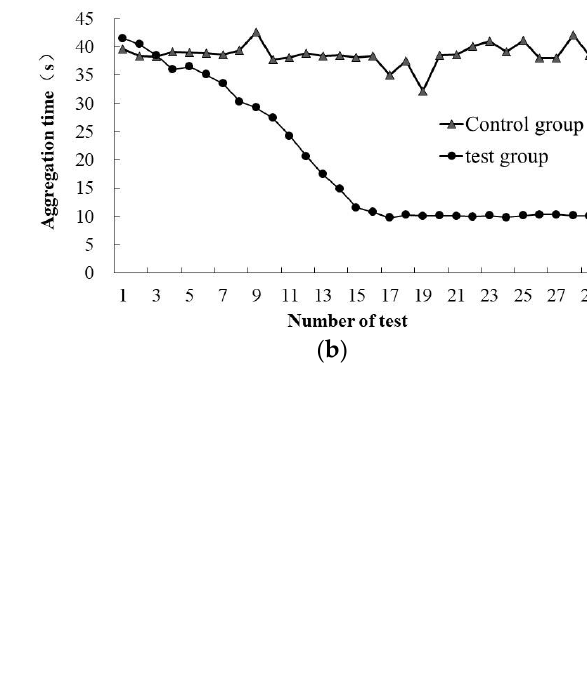
Figure 12. Changes in the response time ( a ), aggregation time ( b ), and aggregation rate ( c ) of juvenile Pagrus major with the elimination of conditioned reflex test.